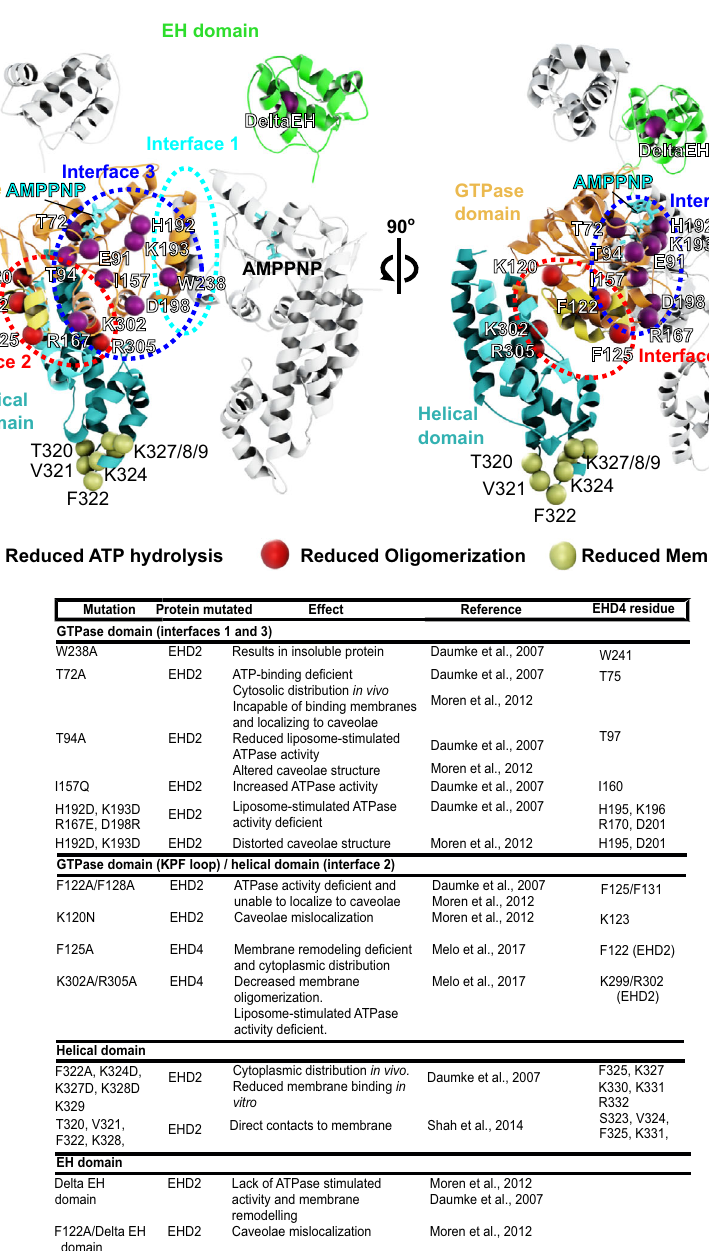
Fig. 3 | The membrane-bound EHD4 structure explains the effects of mutations. Previously reported point mutants of EHD2 and EHD4 were plotted on the EHD4 structure. The effects of the mutations and the relevant literature is listed. All mutagenesis data are consistent with our oligomerized EHD4